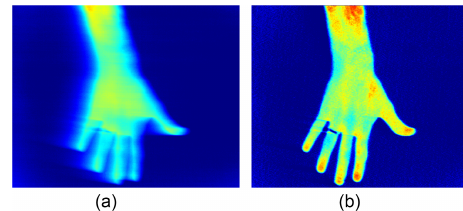
Figure 16. Infrared image of a hand with motion blurring (a) and the reconstructed image (b)